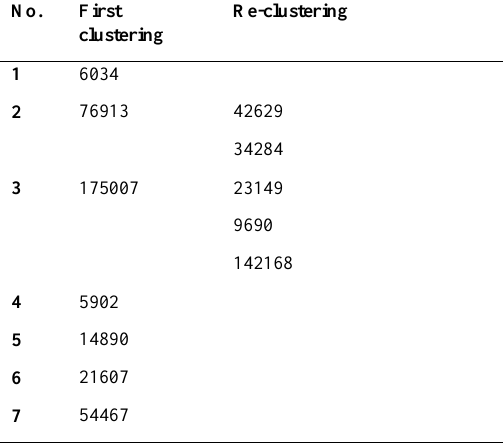
Table 5. Distance of centers from